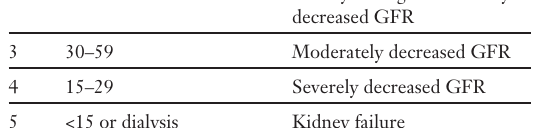
Official classification of chronic kidney dis- ease of the National Kidney Foundation (NKF)